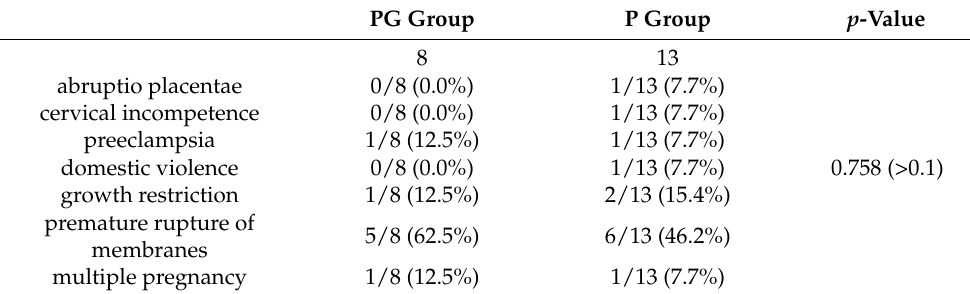
Table 4. Premature birth causes in each group.